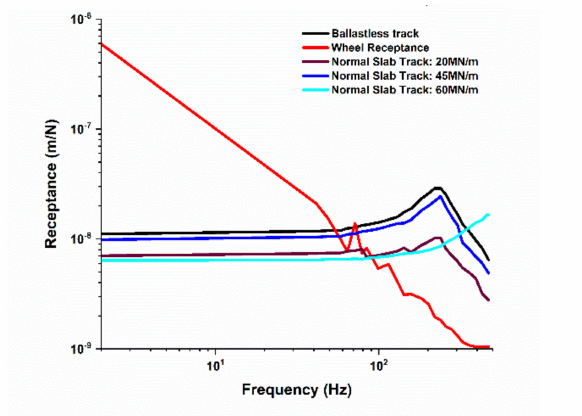
Figure 6. Track and wheel point receptance